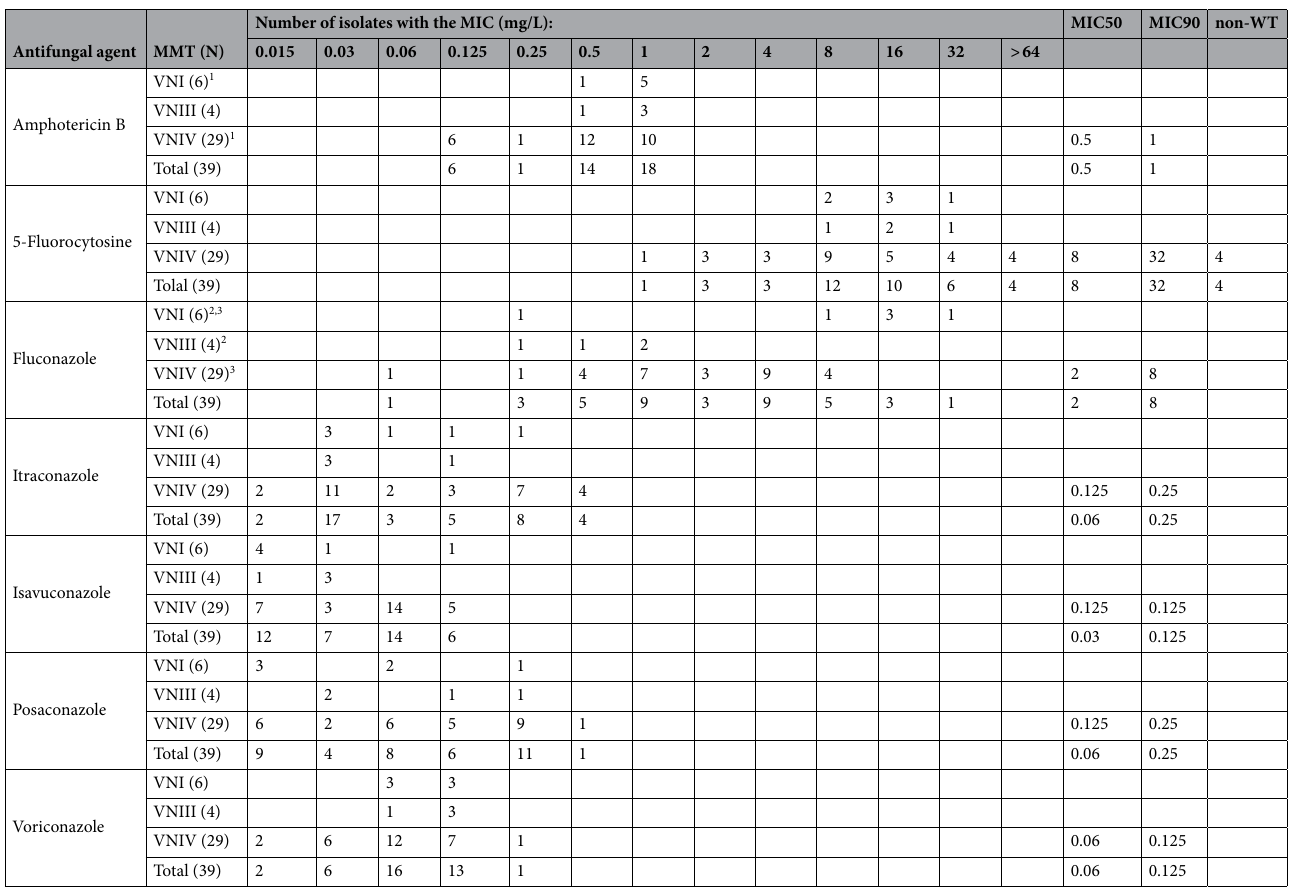
Table 3. Distributions of MIC of amphotericin B, 5-fluorocytosine and triazole derivatives for animal isolates of Cryptococcus neoformans species complex. MIC90—the minimal concentration of the drug with is able to inhibit the growth of 90% strains of tested population. MIC50—the minimal concentration of the drug with is able to inhibit the growth of 50% strains of tested population. 1 p = 0.028 (VNIV vs. VNI). 2 p = 0.003 (VNI vs. VNIII). 3 p = 0.019 (VNI vs.